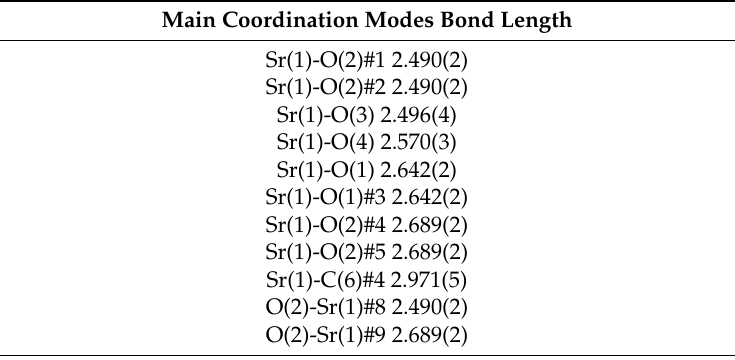
Table 2. Bond lengths [A] and angles [deg] for